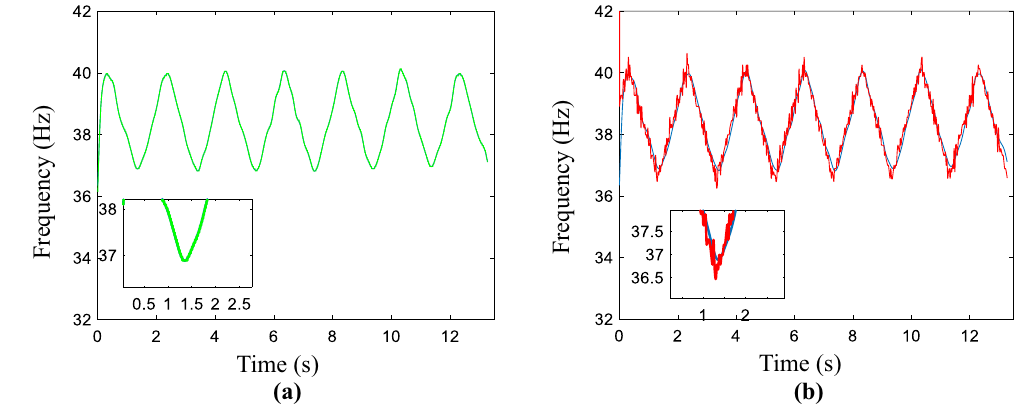
Figure 7. Results of the refined IF. ( a ) The estimated and refined result, ( b ) the real and refined